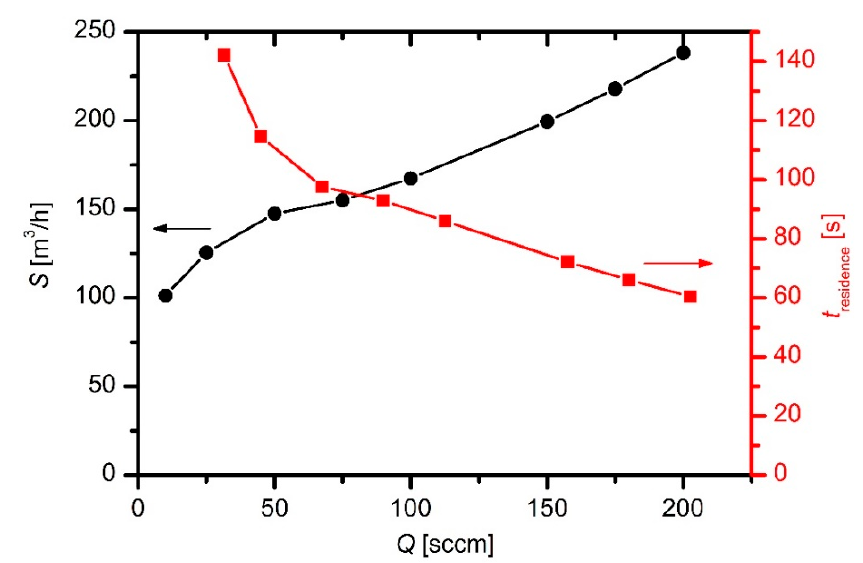
Figure 2. The e ff ective pumping speed and the gas residence time in the plasma reactor versus the HMDSO flow.